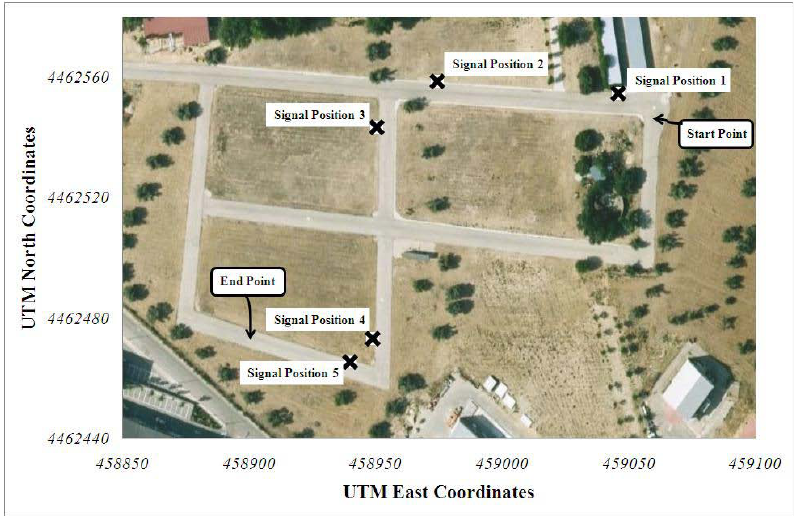
Figure 6. Test circuit in the CAR facilities showing the traffic signal positions for the intelligent Cruise Control using RFID